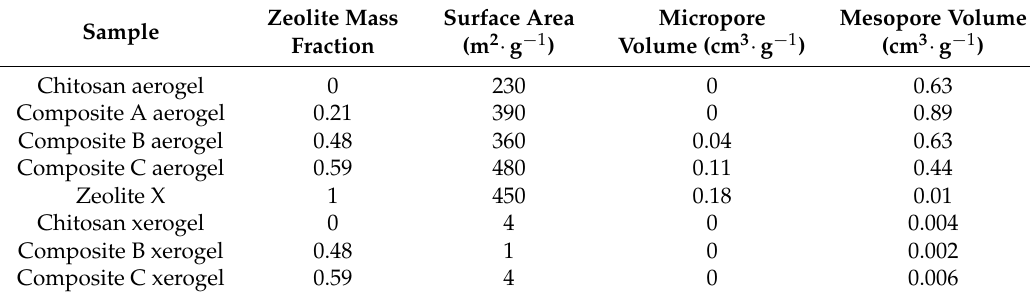
Table 2. Textural properties of isolated components and composites.